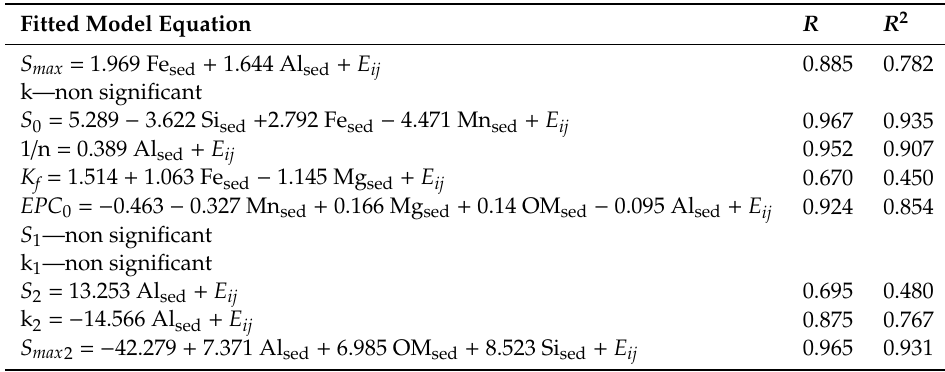
Table 3. Multiple regression analysis of P sorption parameters depending on bottom sediment chemical composition ( n = 12, p ≤ 0.1, raw data was log